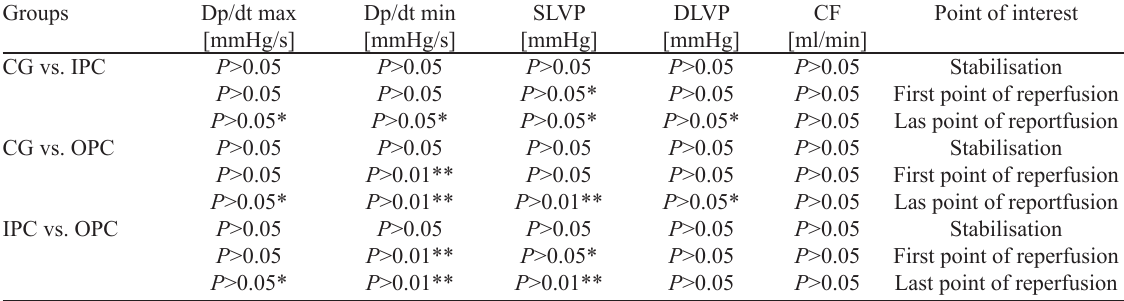
Table 1. Summary table of statistically significant difference between groups in points of interest.